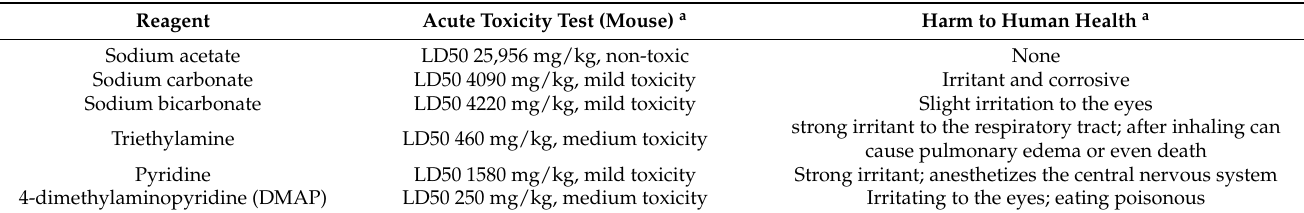
Table 2. Toxicity of some reagents and their harm to human health.